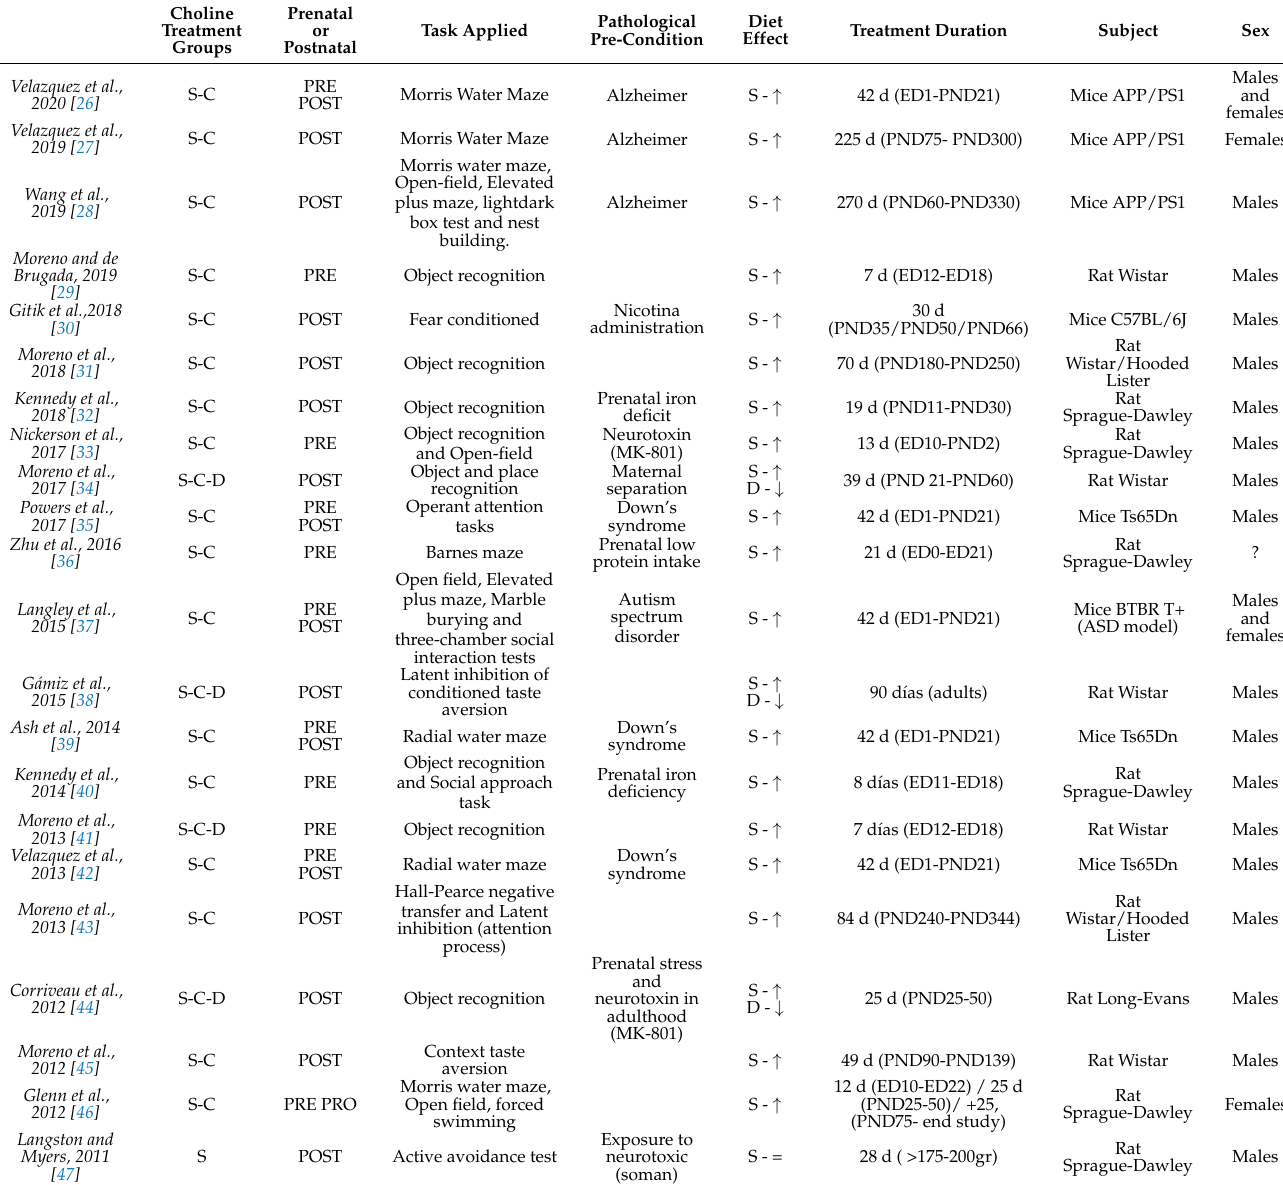
Table 1. Summary table of included studies. Supplemented (S), control (C), deficient (D), prenatal–postnatal supplemen- tation (PRE/POST), improvement ( ↑ ), impairment ( ↓ ), no effect (=), days (d), embryonic day (ED) and postnatal day